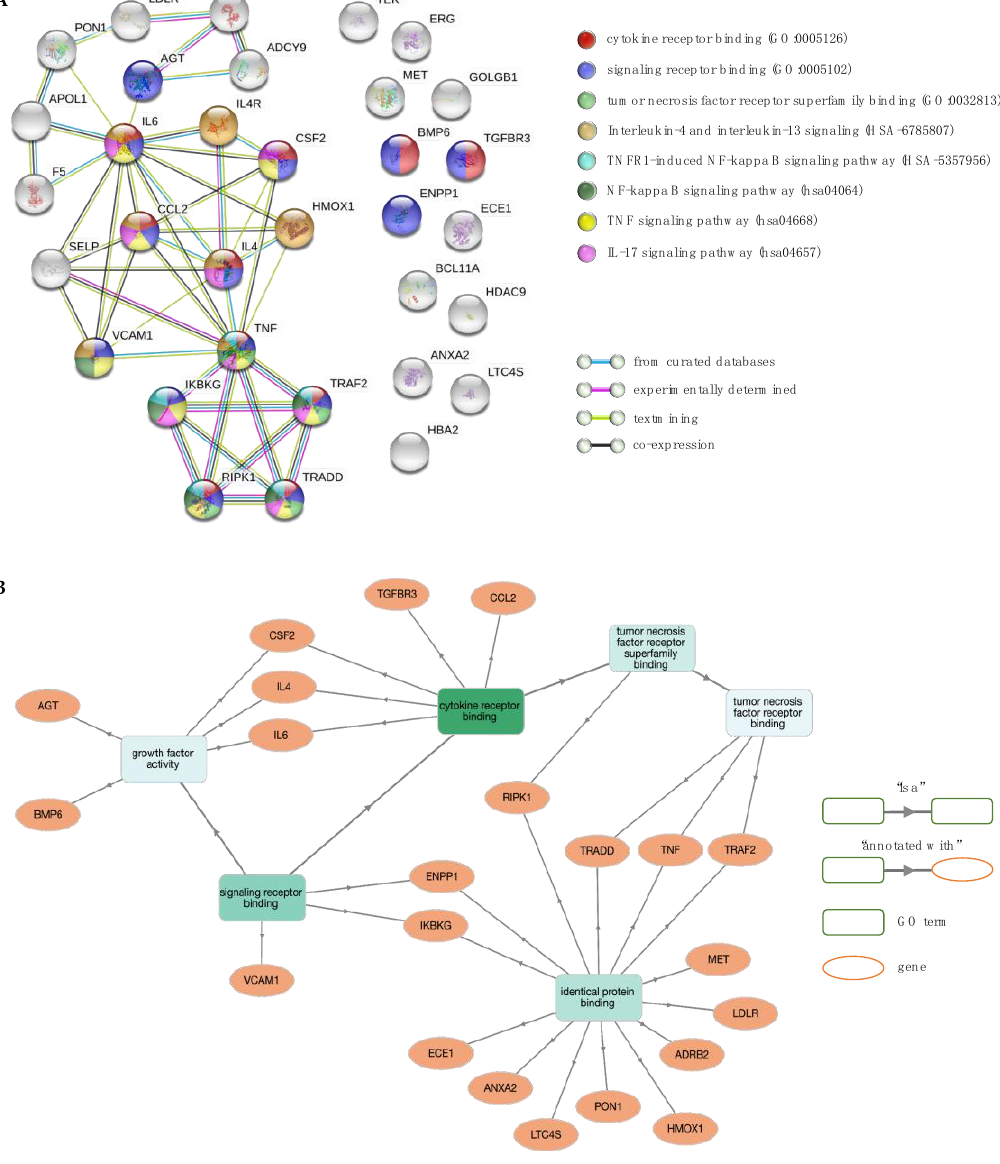
Figure 8. Network and enrichment analysis for stroke. ( A ) The PPI network contains 33 nodes (proteins; circles) connected by edges (protein–protein interactions; horizontal lines). Coloured nodes highlight proteins associated with significant molecular function (MF) terms and biological pathways. ( B ) GO MF enrichment analysis using GOnet ( q value ≤0.01; p value ≤1.94 × 10 –5 ). Green colour intensifies as the significance level of enrichment decreases.